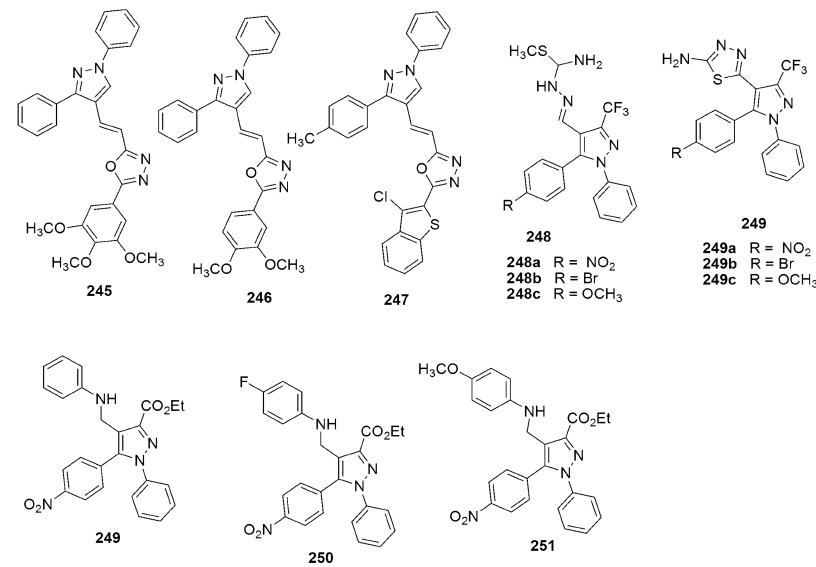
Figure 13. Structures of pyrazoles derivatives with antileishmanial activity.